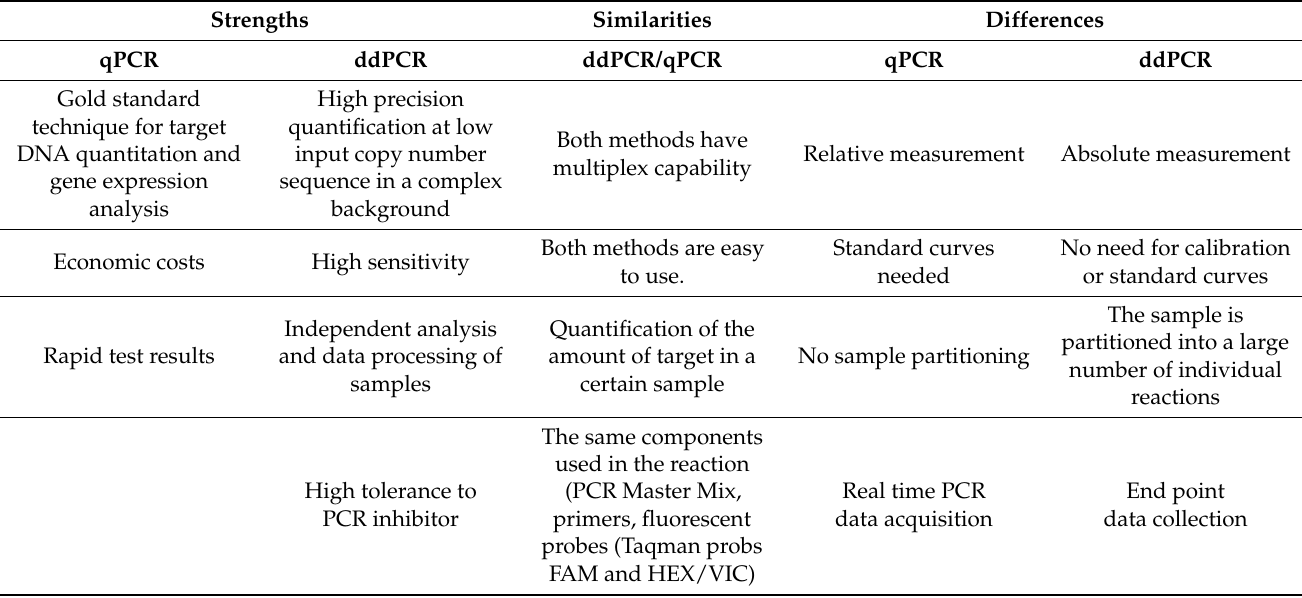
Table 1. The similarities and differences between ddPCR and